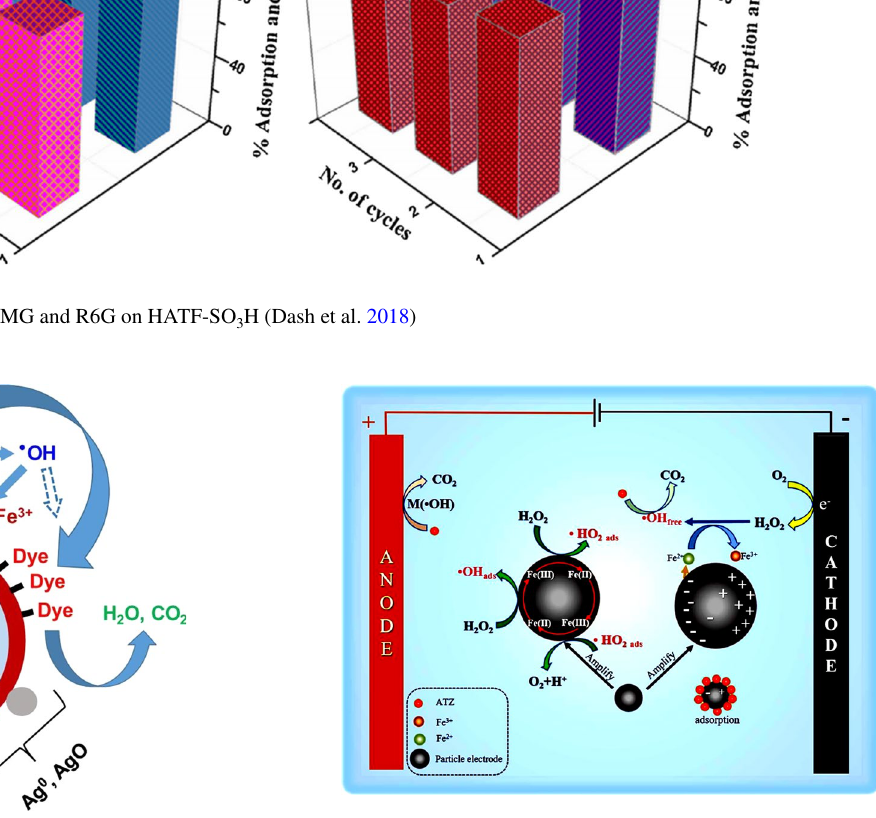
Fig. 25 Schematic representation of degradation of atrazine and regeneration of FRPEs (Teng et al.